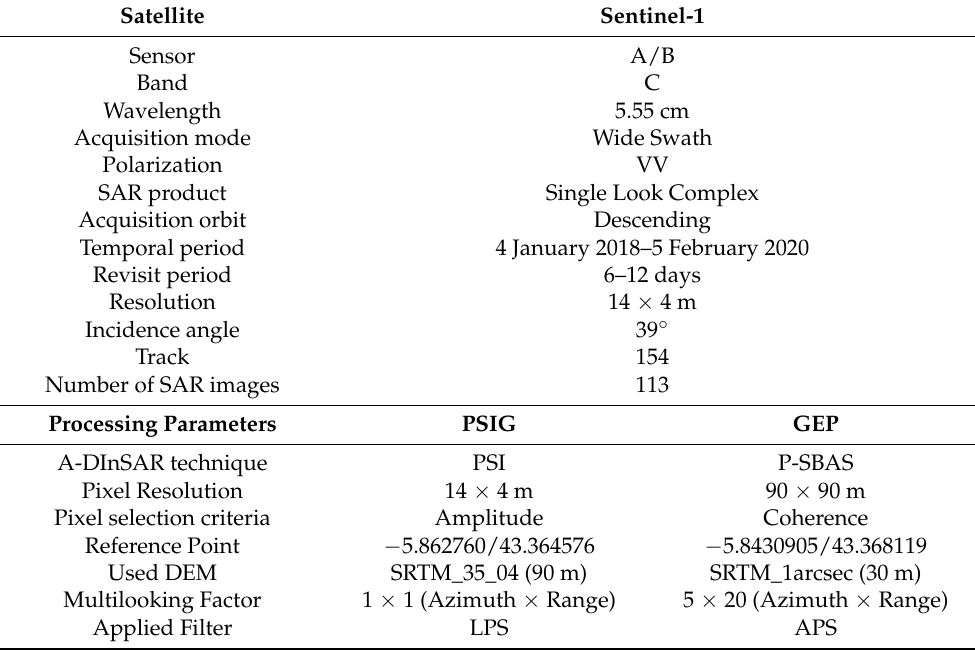
Table 1. Main acquisition parameters of the SAR satellite dataset used and principal processing parameters of both